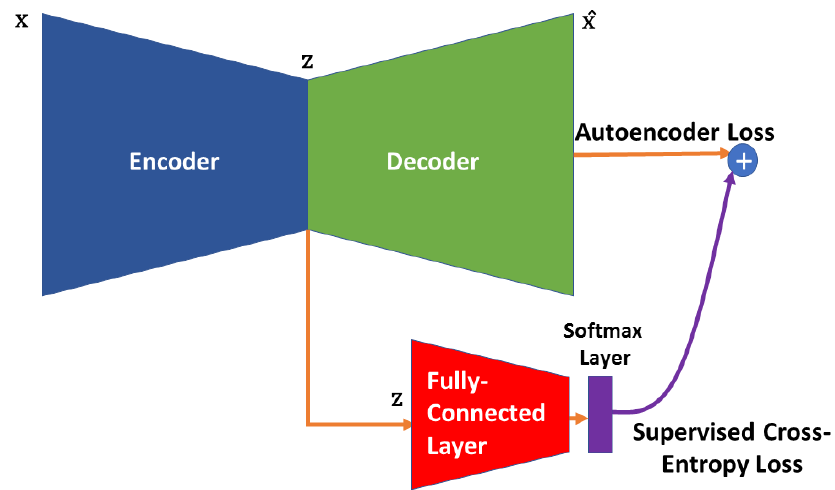
Figure 2. Schematic of a single layer Supervised Autoencoder Neural Network (SAE-NN).